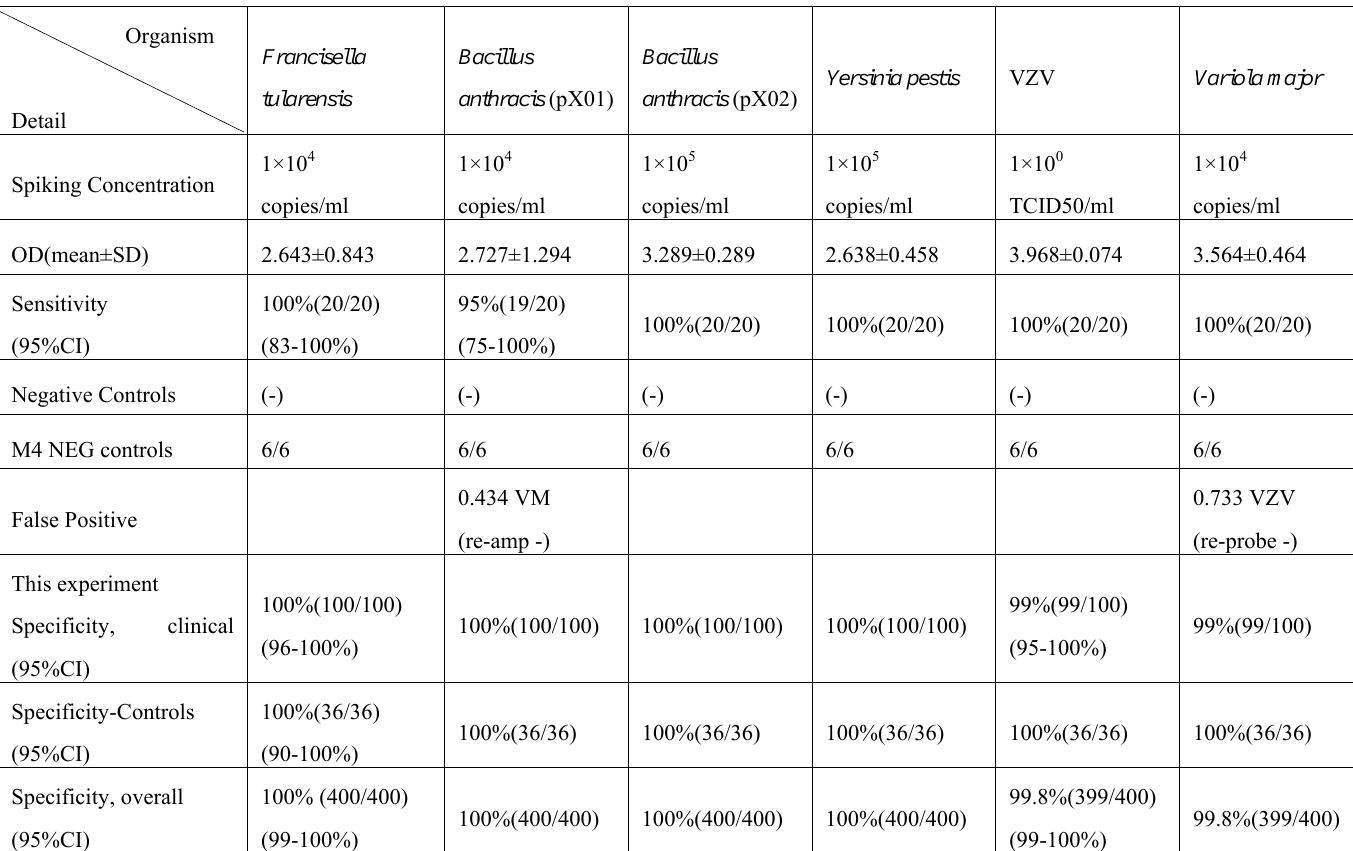
Table 4. The sensitivity and specificity of BioT DNA and BioT RNA assays in spiked clinical